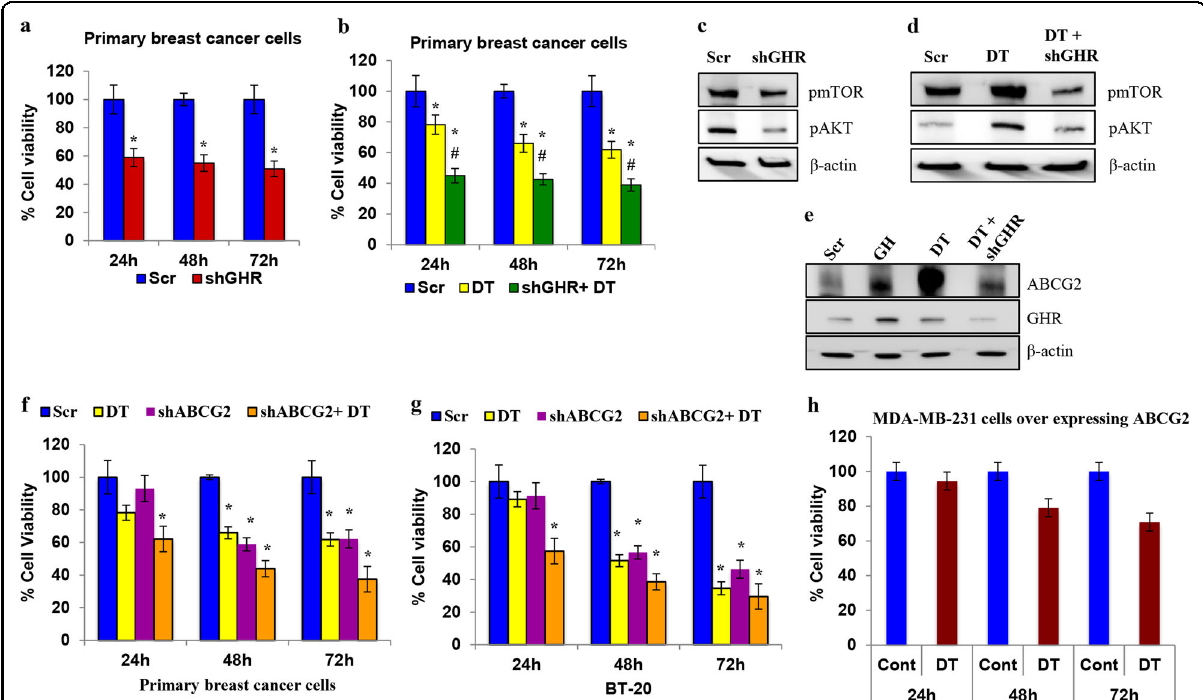
Fig. 5 GHR knockdown in primary breast cancer cells sensitized them to DT by inhibiting ABCG2 expression. a GHR knockdown signi fi cantly decreased the cell viability of primary breast cancer cells. GHR silencing effectively reduced the viability of the cells at all time points. b GHR silencing sensitized the cells to DT. DT treatment reduced the cell viability and the combination of GHR silencing + DT treatment further reduced the cell viability. (* denotes p < 0.05 signi fi cance in Scr vs. shGHR or DT and # indicates p < 0.05 signi fi cance in DT vs. shGHR + DT). c and d GHR knockdown alone and in combination with DT reduced the levels of pmTOR and pAKT. e GHR activation and DT treatment increased the expression of ABCG2. Both GH and DT induced ABCG2 expression in primary breast cancer cells, and GHR knockdown inhibited the DT-induced increase in ABCG2. f and g ABCG2 knockdown sensitized primary breast cancer cells ( f ) and BT-20 cells ( g ) to DT. ABCG2 silenced cells treated with DT signi fi cantly reduced viability compared with the cells treated with DT alone. (* represents p < 0.05 signi fi cance in Scr vs. DT or shABCG2 + DT and # indicates p < 0.05 signi fi cance in DT vs. shABCG2 + DT). h Overexpression of ABCG2 reduced the effectiveness of DT in breast cancer cells. MDA-MB-231 cells overexpressing ABCG2 were treated with DT and the viability was assessed. DT was not effective in reducing the cell viability of ABCG2 overexpressing cells. All the experiments were carried out three times, independently. Cell viability assay were repeated three times with at least fi